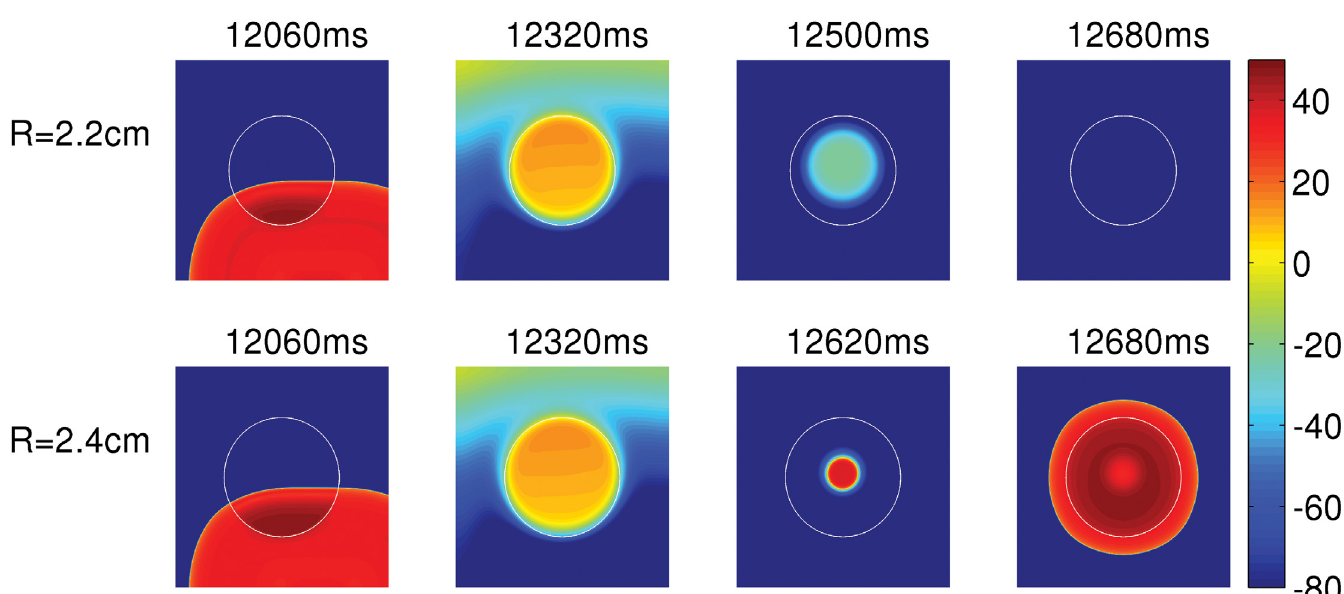
Fig 4. The dependence of the triggering of PVCs on the size R of an EAD clump. Pseudocolor plots of V m , which shows that the clump with radius, R = 2.2 cm (top panel) does not trigger PVCs, whereas the bigger clump with R = 2.4 cm (bottom panel) triggers